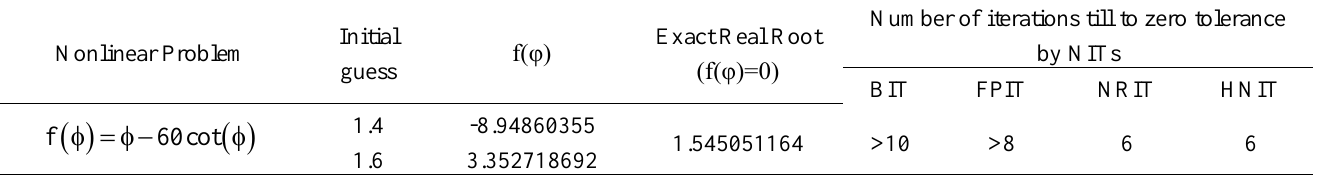
Solution of (iv) by NITs and comparison of the models. Nonlinear